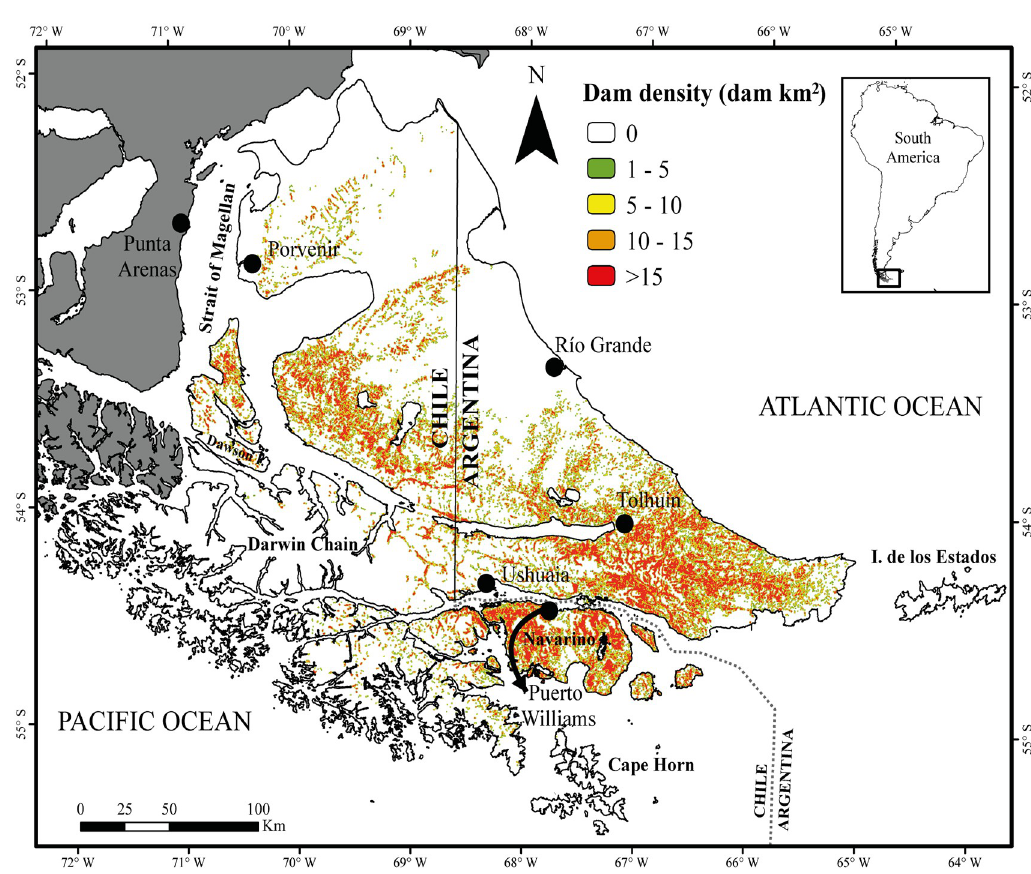
Fig 4. Beaver dam density (dams per km 2 ) in a search radius of 1 km 2 . The zone that was not analyzed is in gray.